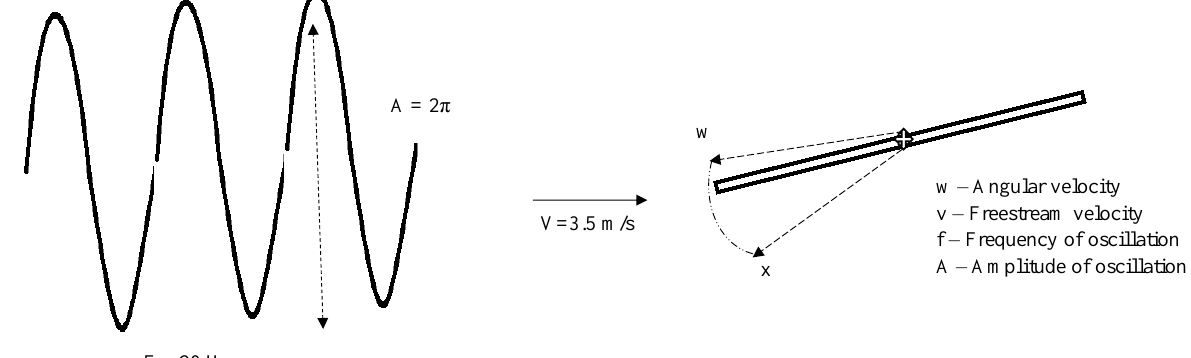
Figure 15. Flapping physics for the computational fluid dynamic ornithopter analysis.